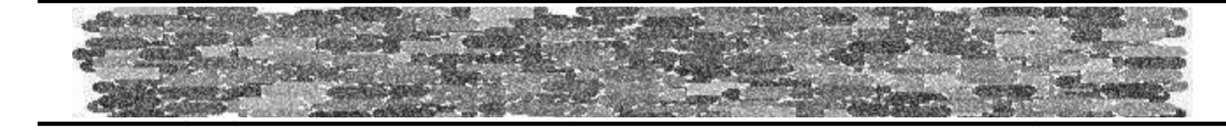
Fig 2. Simulated blood flow. Representative image of computer-generated simulation of the blood flow.